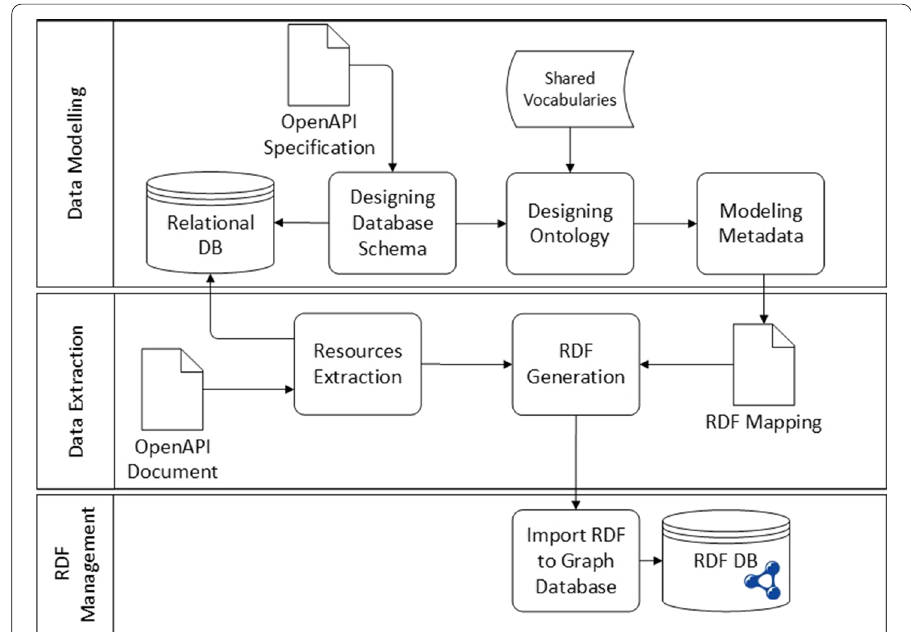
Fig. 2 RDF-based semantic web services transformation proposed framework